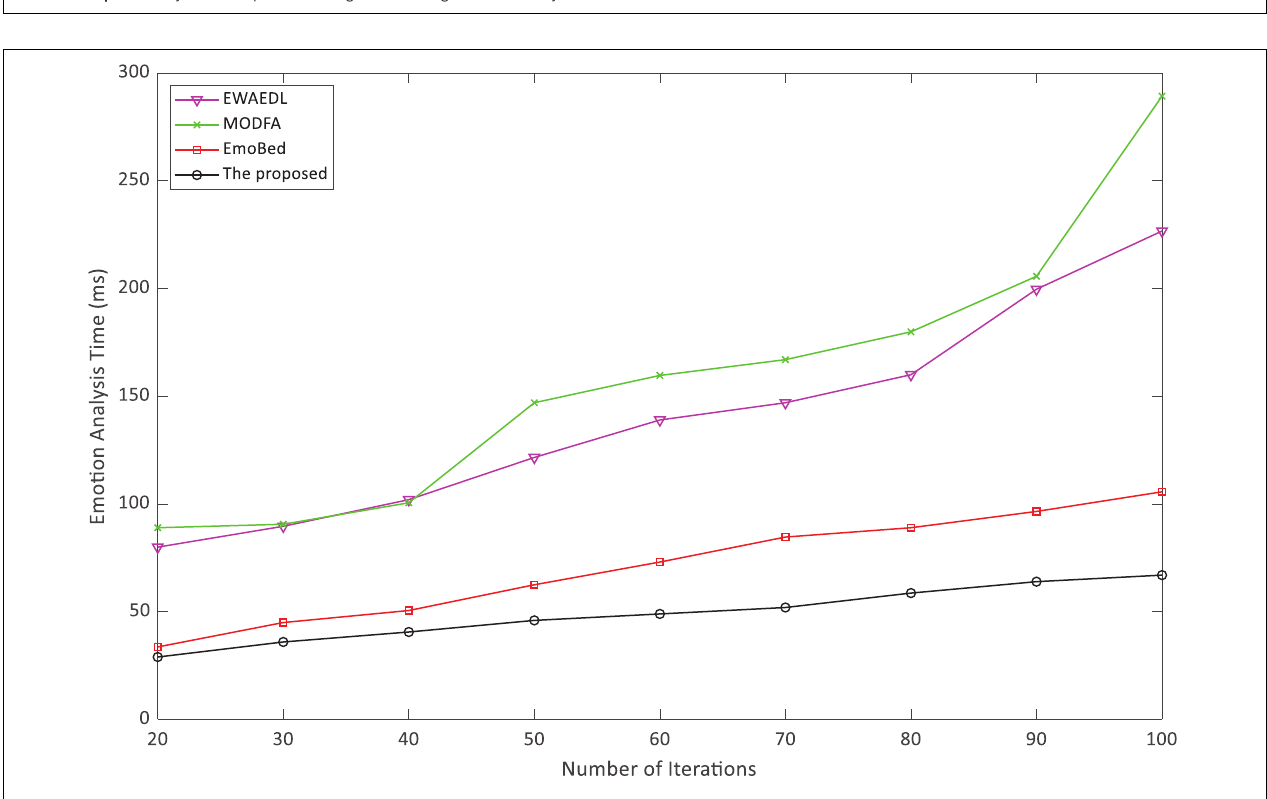
FIGURE 4 | Emotion analysis time of the experiential English